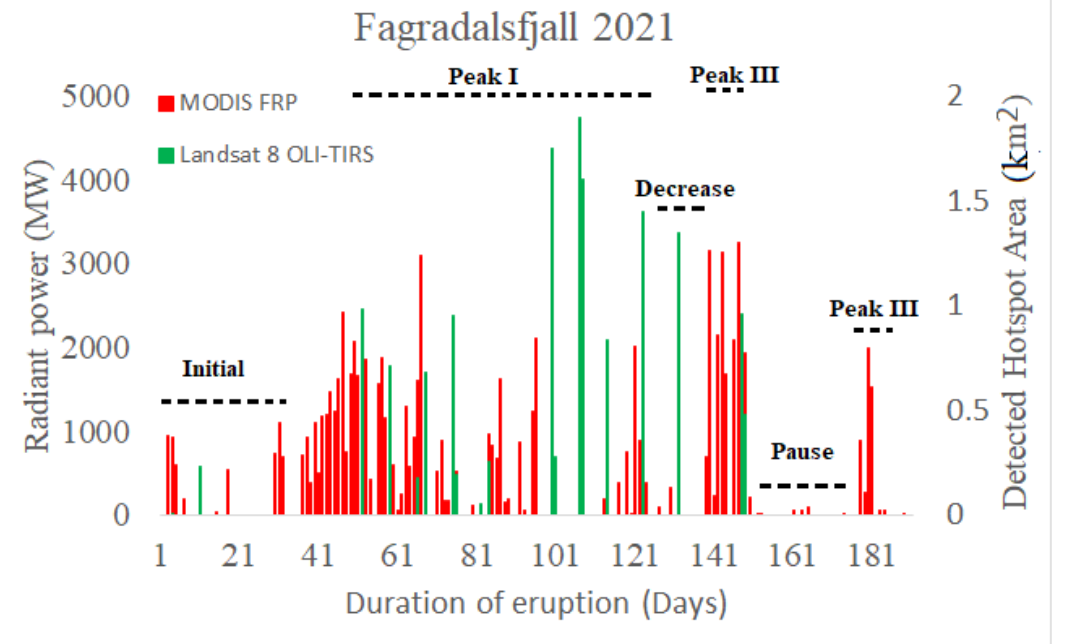
Figure 2. The time series of radiant power detected (red) during the 2021 Fagradalsfjall eruption derived from MODIS FRP; eruption stages (dashed line) in the 2021 Fagradalsfjall eruption based on the radiant power pattern. This period of eruptive pattern was divided into four stages (initial, peaks, decrease and pause stages). Temporal area covered by detected active lava hotspot (green) derived from Landsat-8 OLI-TIRS.